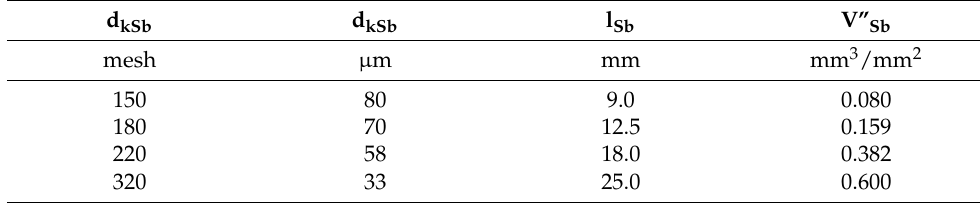
Table 2. Significant sharpening parameters.